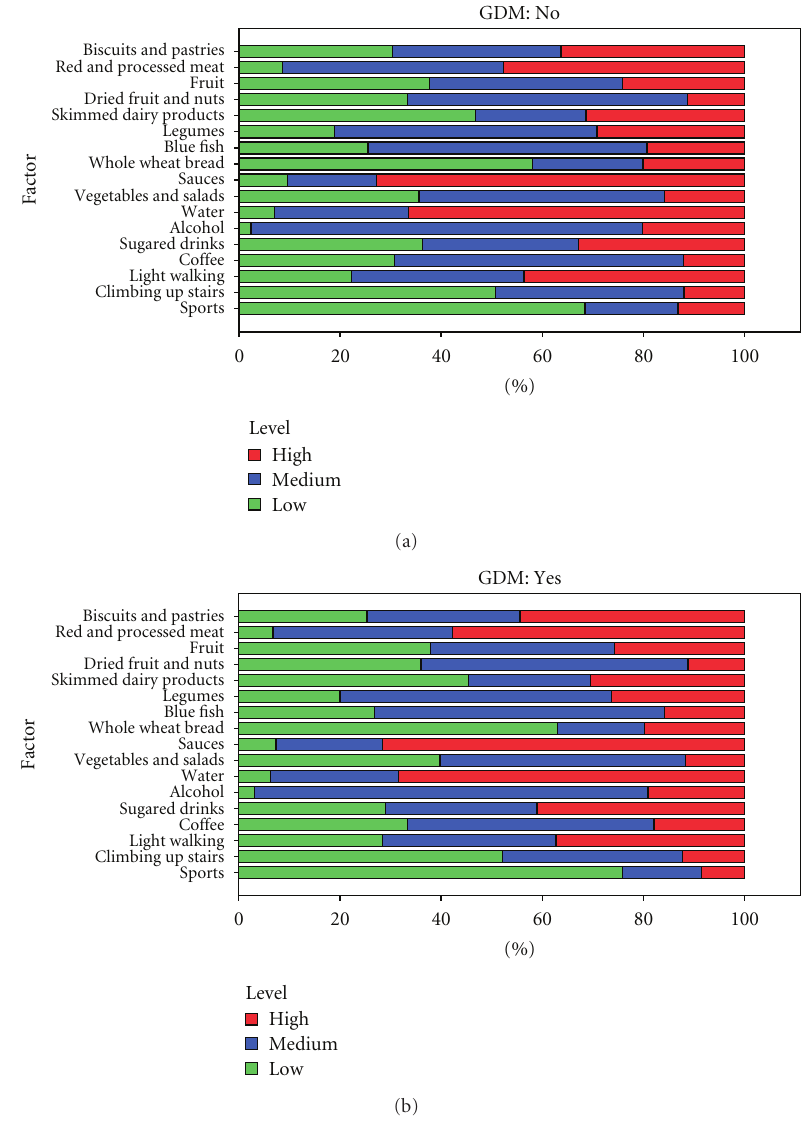
Figure 1: Lifestyle patterns of our study population, according to the diagnosis of GDM. For each of the elements considered, for simplifying purposes, a categorical schematic scale of three levels—low, medium, and high—was elaborated to classify the quantity of intake or practice. The limits varied depending on the factor. Biscuits and pastries < 2/week, 2–4/week, > 4/week; red and processed meats < 3/week, 3–6/week, > 6/week; fruit < 6/week, 6–12/week, > 12/week; dried fruits and nuts 0/week; 1–3/week; > 3/week; skimmed dairy products < 3/week, 3– 6/week, > 6/week; legumes < 1/week, 1-2/week, > 2/week; blue fish < 3/week, 3–6/week, > 6/week; whole wheat bread < 1/week, 1–3/week, > 3/week; sauces < 2/week, 2–4/week, > 4/week; vegetables and salads < 6/week, 6–12/week, > 12/week; water no, shared, exclusive; alcohol 1– 4/day, 4–6/day, > 6/day; sugared drinks < 2/week, 2–4/week, > 4/week; co ff ee 0-1/day 2-3/day, > 3/day; light walking < 30 minutes/day, 30–60 minutes/day, > 60 minutes/day; climbing up stairs < 4/day, 4–16/day, > 16/day; sports < 2 days/week, 2-3 days/week, > 3 days/week. (“ < ” means less than; “ > ” means more